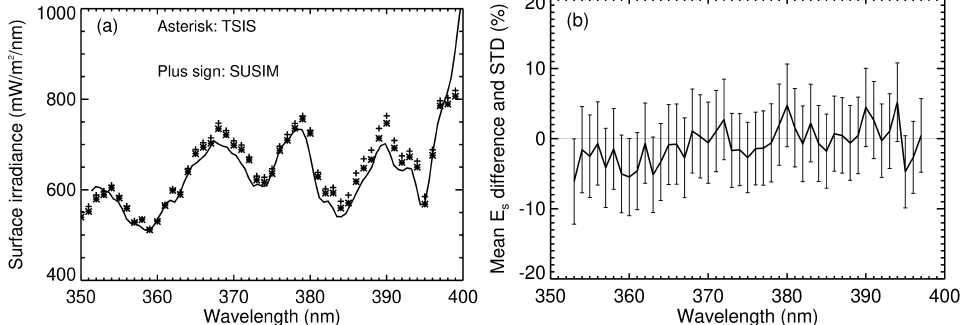
Figure 2. ( a ) A comparison of the smoothed E s measurements from MOBY (solid line) and OMI (symbols) using the Solar Ultraviolet Spectral Irradiance Monitor (plus signs) and TSIS (asterisks) extraterrestrial solar irradiance spectra for a selected OMI pixel. ( b ) The mean difference and standard deviation between the OMI-derived surface irradiance and the MOBY-measured